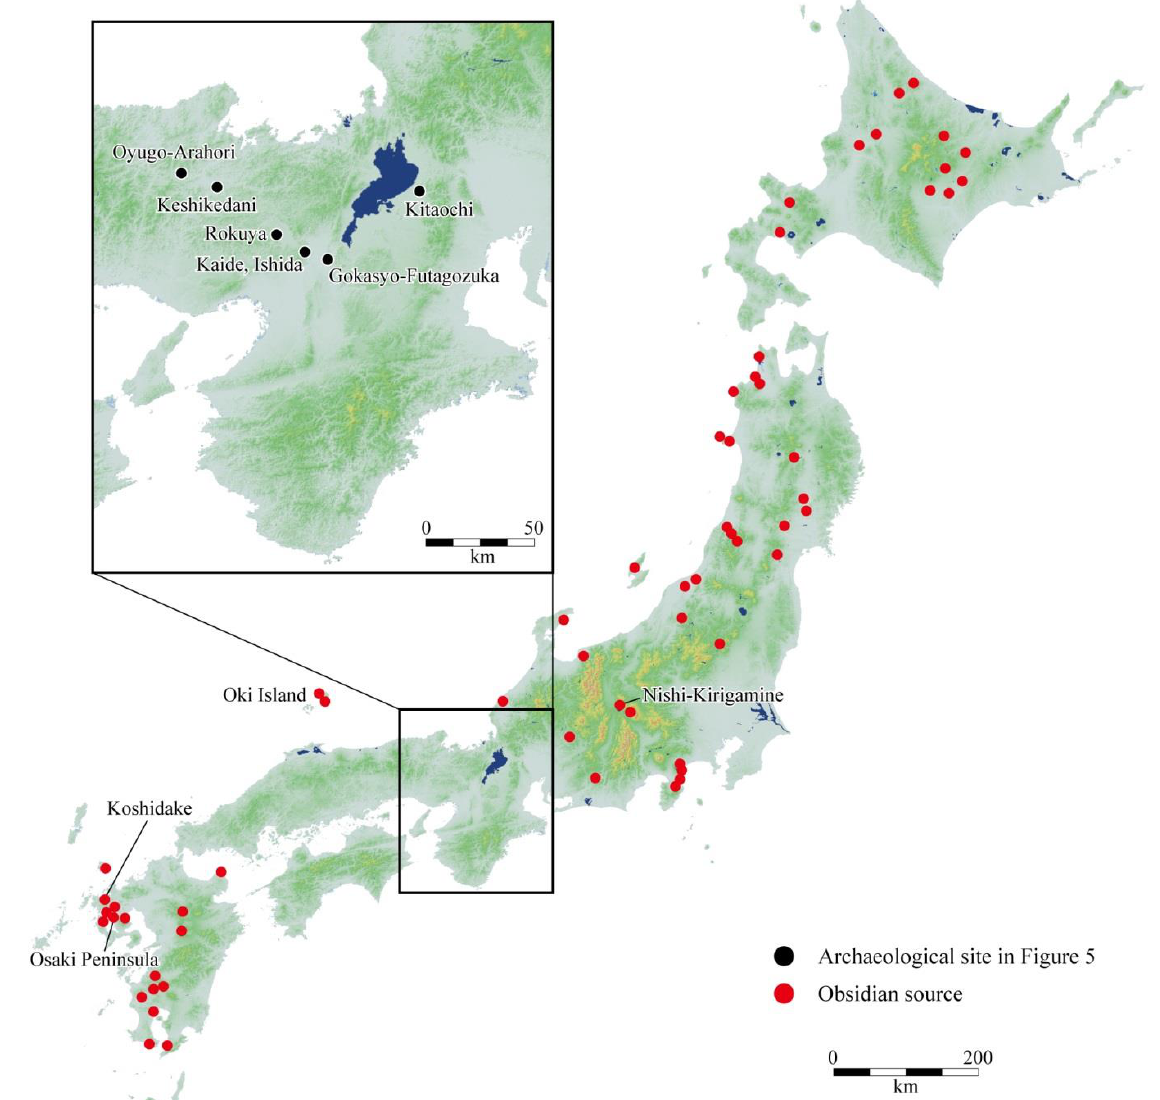
Figure 4. Obsidian source areas of Japanese Archipelago (after Sugihara 2011) and obsidian from archaeological sites discovered in Kansai region (made with Kashmir